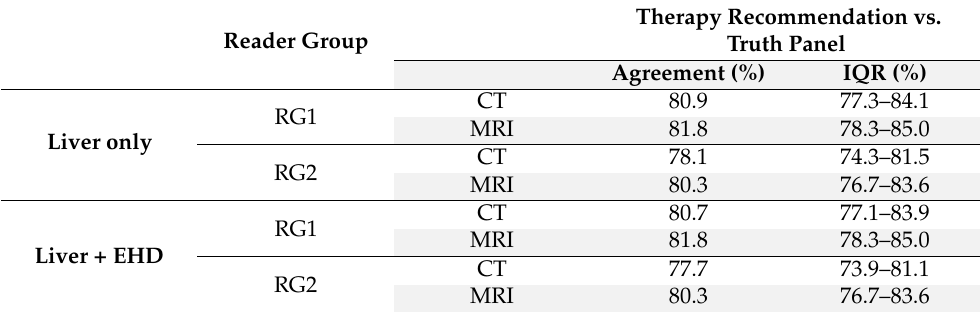
Table 3. Most appropriate therapy recommendation by RG1 and RG2 based on hepatic disease only and both hepatic disease and EHD. The therapy recommendation was compared to the recommenda- tion by the truth panel (based on hepatic disease and EHD in all imaging modalities, respectively). Therapy Recommendation vs. Reader Group Truth Panel Agreement (%) IQR (%) RG1 Liver only